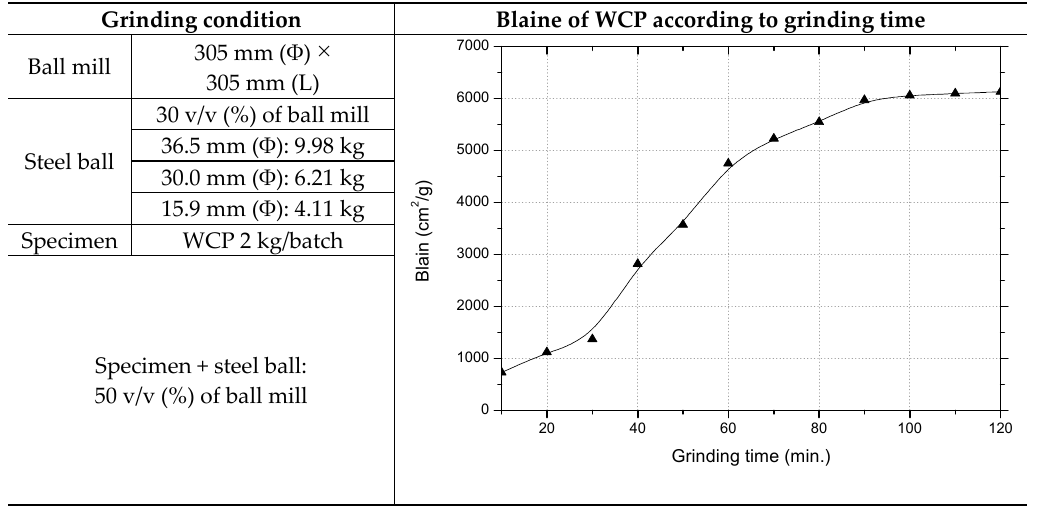
Figure 4. Blaine change according to grinding of WCP.